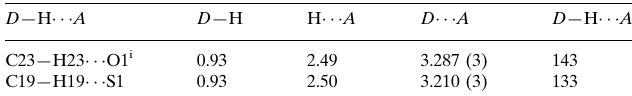
Hydrogen-bond geometry (A˚ , (cid:2)